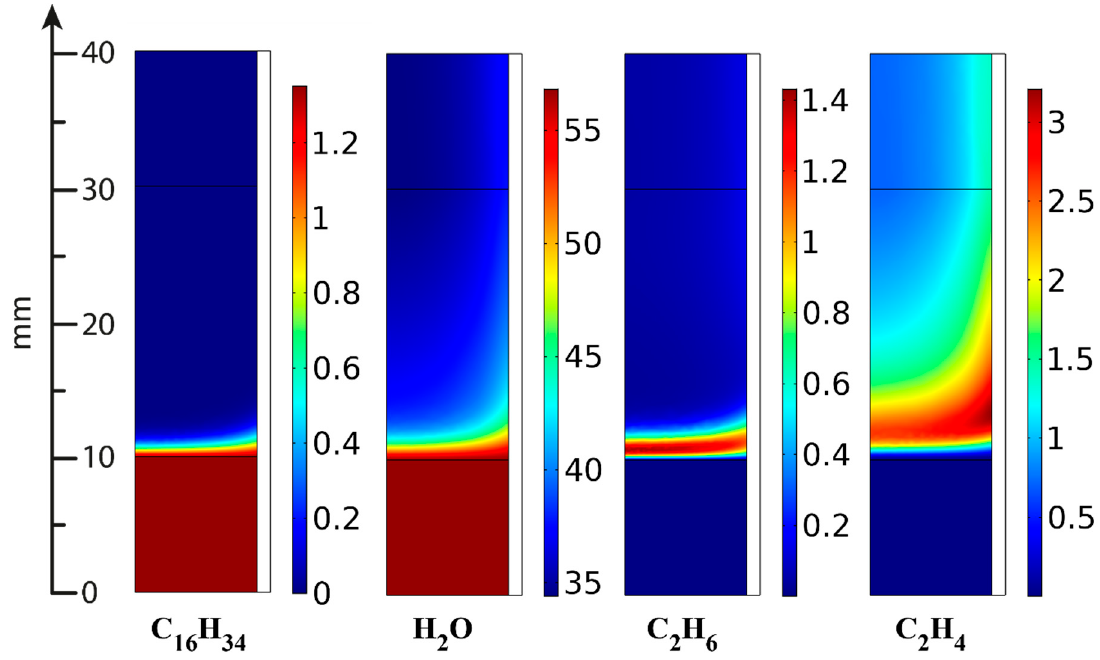
Figure 21. Gas velocity ( left ), temperature distribution ( center ) and oxygen concentration ( right ; vol.%) in ATR mode [95].